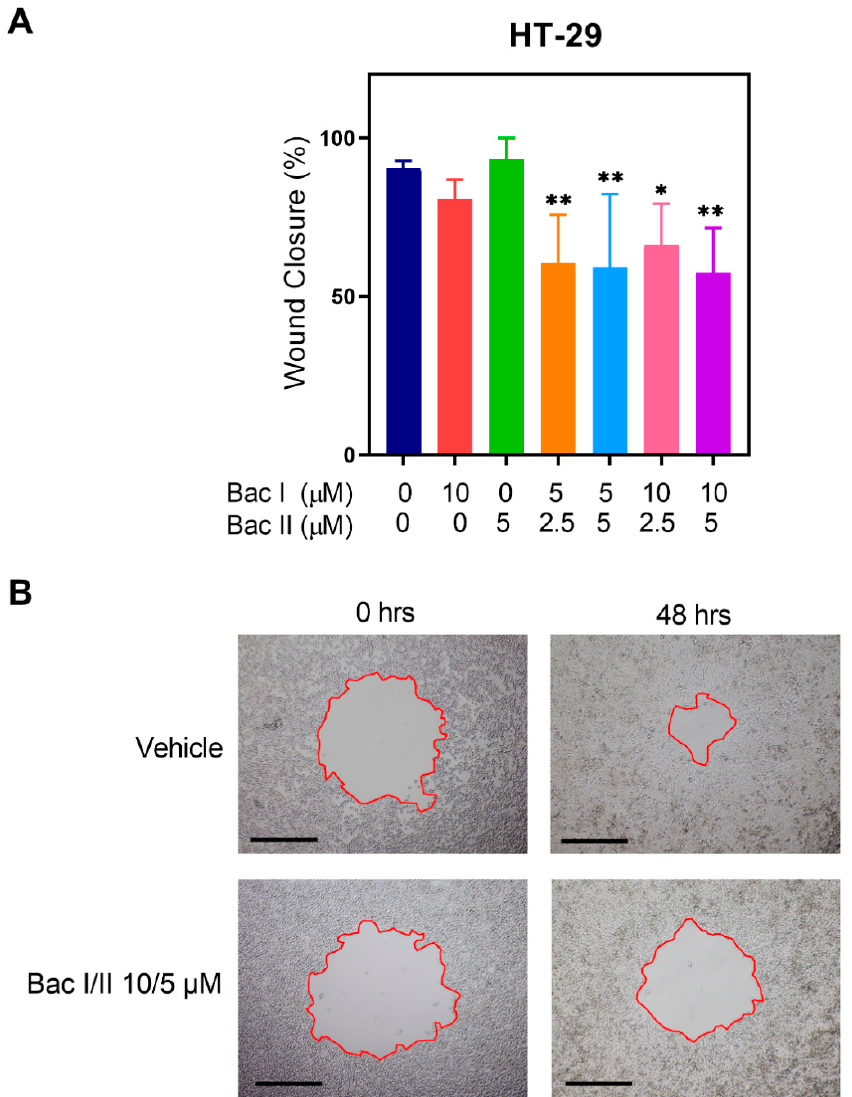
Figure 3. Bac I and II combined impaired migration of HT-29. ( A ) HT-29 was treated with bac I and bac II, either alone or in combination, and wound closure was measured after 48 h. Data represent the mean wound closure as a percentage of 5 to 6 replicates. Error bars represent the SD. Significant difference as compared to vehicle is indicated by asterisks (* p < 0.05; ** p < 0.01). ( B ) Representative images of scratch wounds at times 0 and 48 h are shown for treatment with vehicle and bac I/II 10/5 µ M. Magnification × 40, scale bar = 0.5 mm.